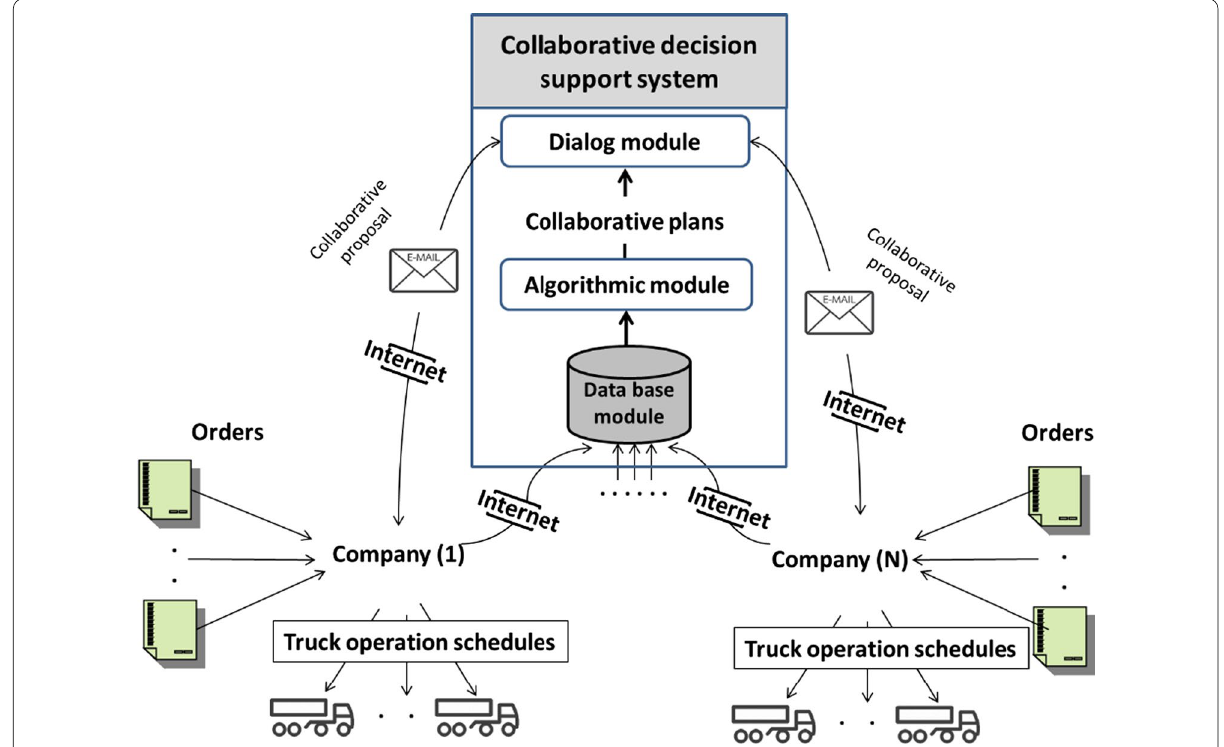
Fig. 1 The basic structure of a